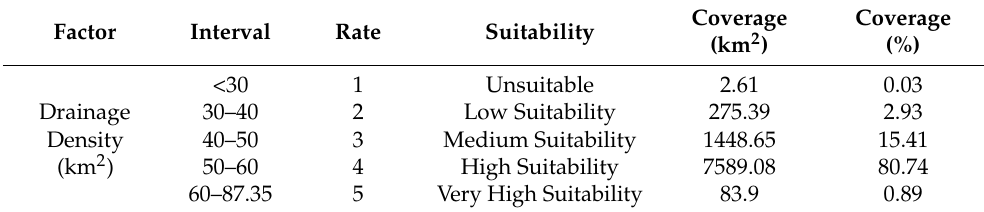
Figure 10. Study area’s drainage density map drainage density ( left ); reclassified drainage density ( right ). Table 4. Distribution of drainage density suitability